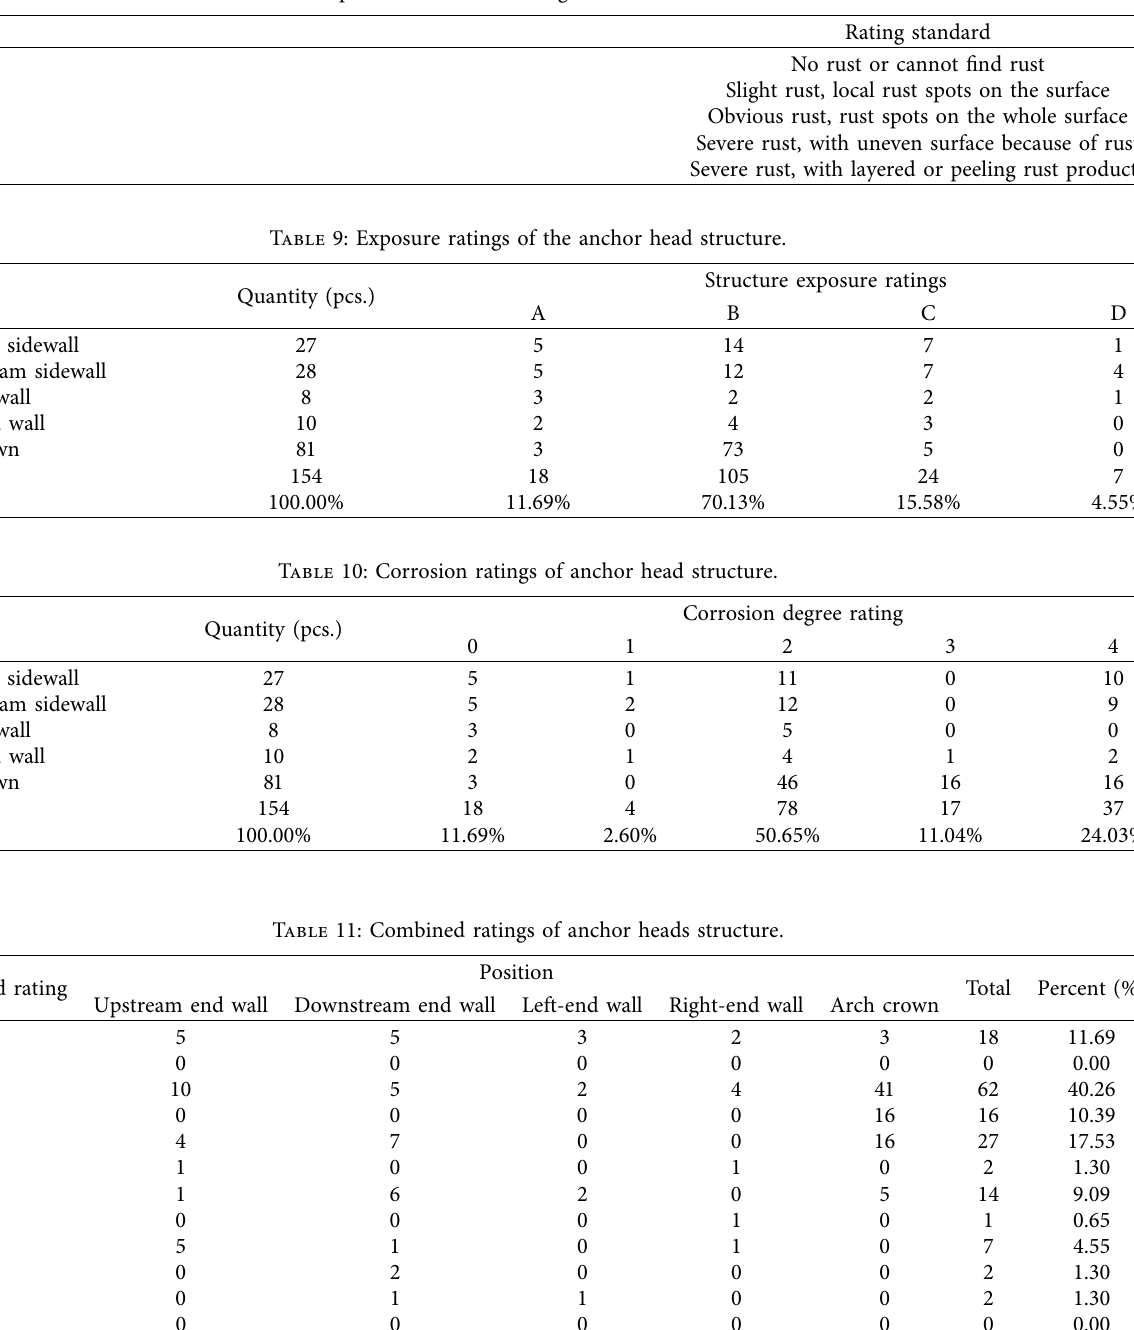
Table 8: Description of corrosion ratings of the anchor head structures.